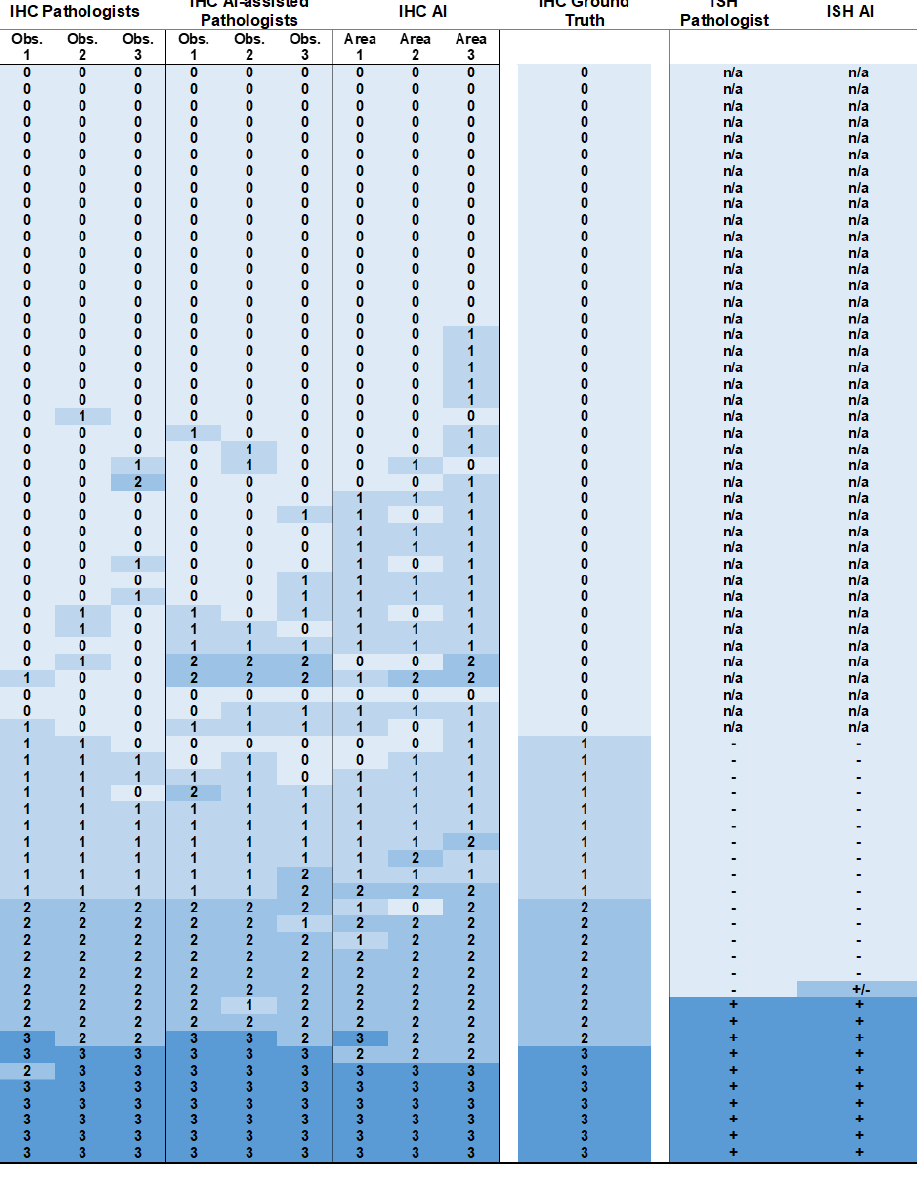
Figure 2. Heatmap representation of HER2 scoring for primary B5b invasive breast carcinomas. IHC scores (0, 1, 2, 3) are shown for Pathologists, AI-assisted Pathologists, and AI in comparison to the ground truth. ISH was designated as negative ( − ), positive (+), or requiring further assessment (+/ − ).